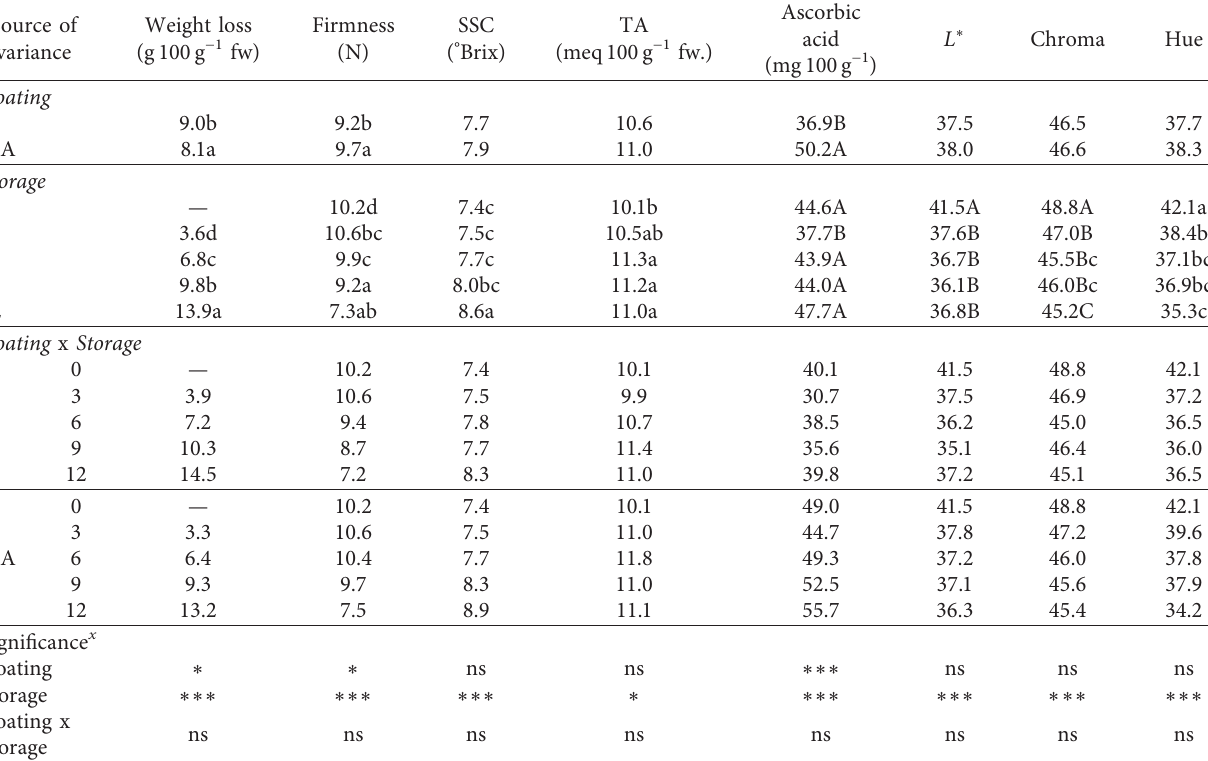
Table 1: Chemical and physical parameters of strawberries coated with cactus mucilage +ascorbic acid (MA) or uncoated (C) during storage at 4 ° C.